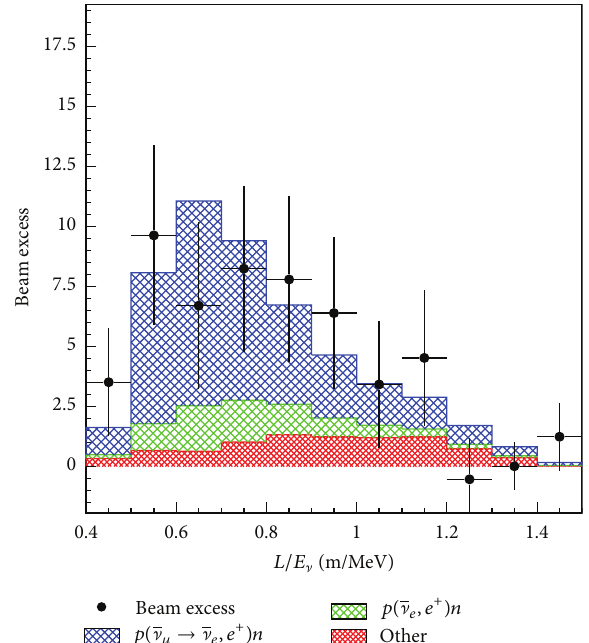
Figure 6: The LSND 𝐿/𝐸 ] distribution for events with 𝑅 𝛾 > 10 and 20 < 𝐸 𝑒 < 60 MeV, where 𝐿 is the distance travelled by the neutrino in meters and 𝐸 ] is the neutrino energy in MeV. The data agree well with the expectation from neutrino background and neutrino oscillations at low Δ𝑚 2 .